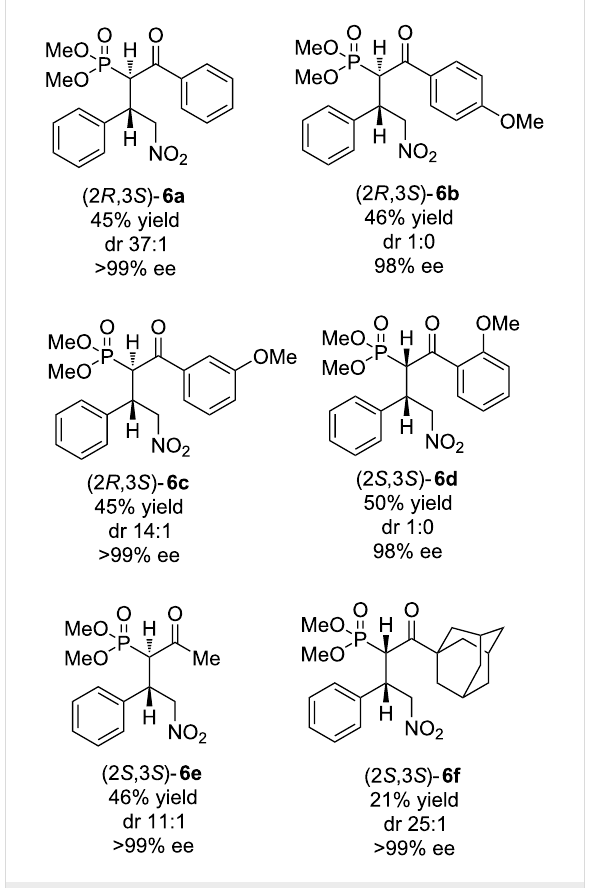
Figure 2: Starting nonracemic